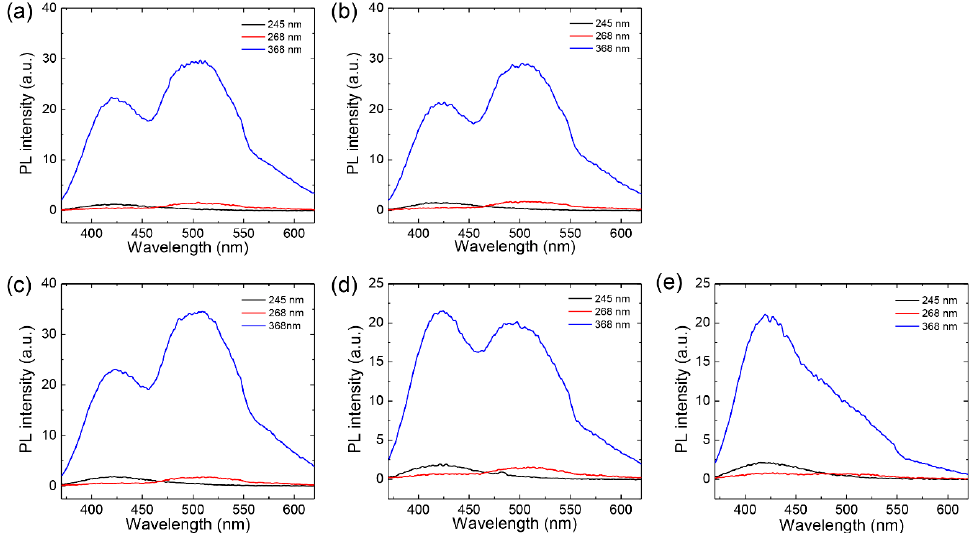
Figure 6. Photoluminescence (PL) spectra from GQD solutions obtained after two filtration modes. ( a , b ) PL spectra from (a) feed and (b) permeate solutions in dead-end filtration. ( c – e ) PL spectra from (c) feed, (d) retentate, and (e) permeate solutions in cross-flow filtration. The feed solutions used in two filtration modes was prepared by the same synthetic methods of GQDs.